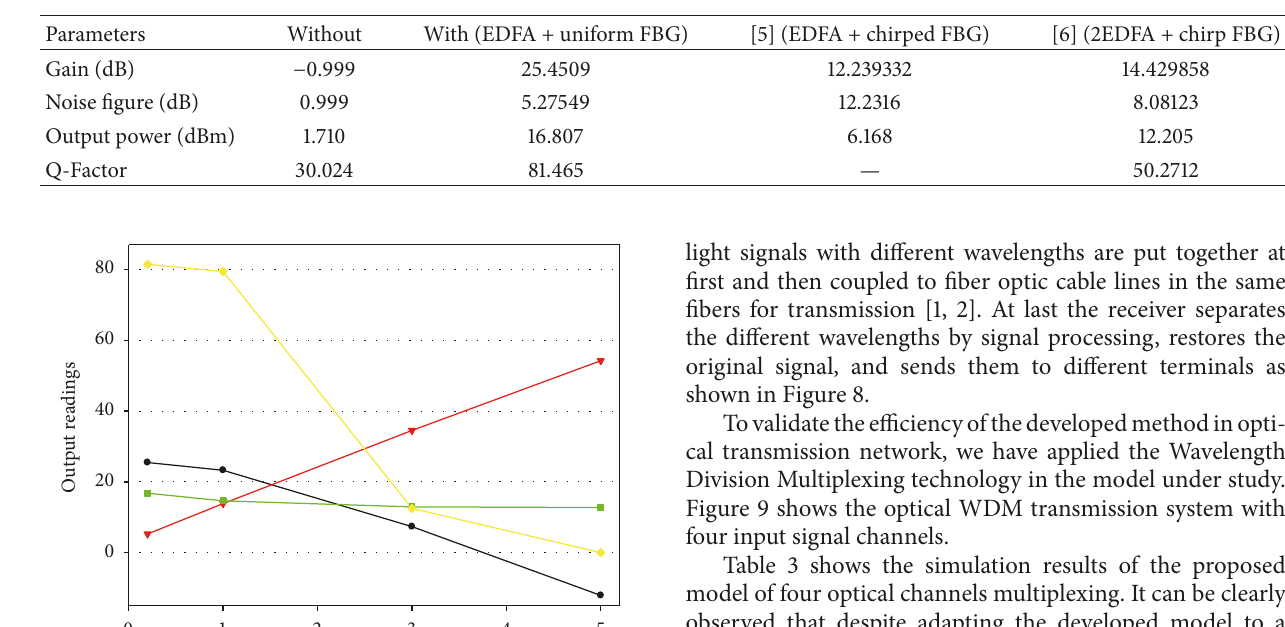
Table 2: Comparison parameters with proposed model and previous models.